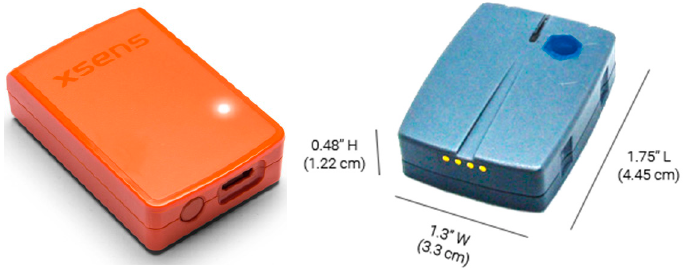
Figure 2. MTw Awinda sensor 47 × 30 × 13 mm, mass 16 g ( left ); and Noraxon Ultium Motion sensor 44.5 × 33 × 12.2 mm, mass 19g ( right ).